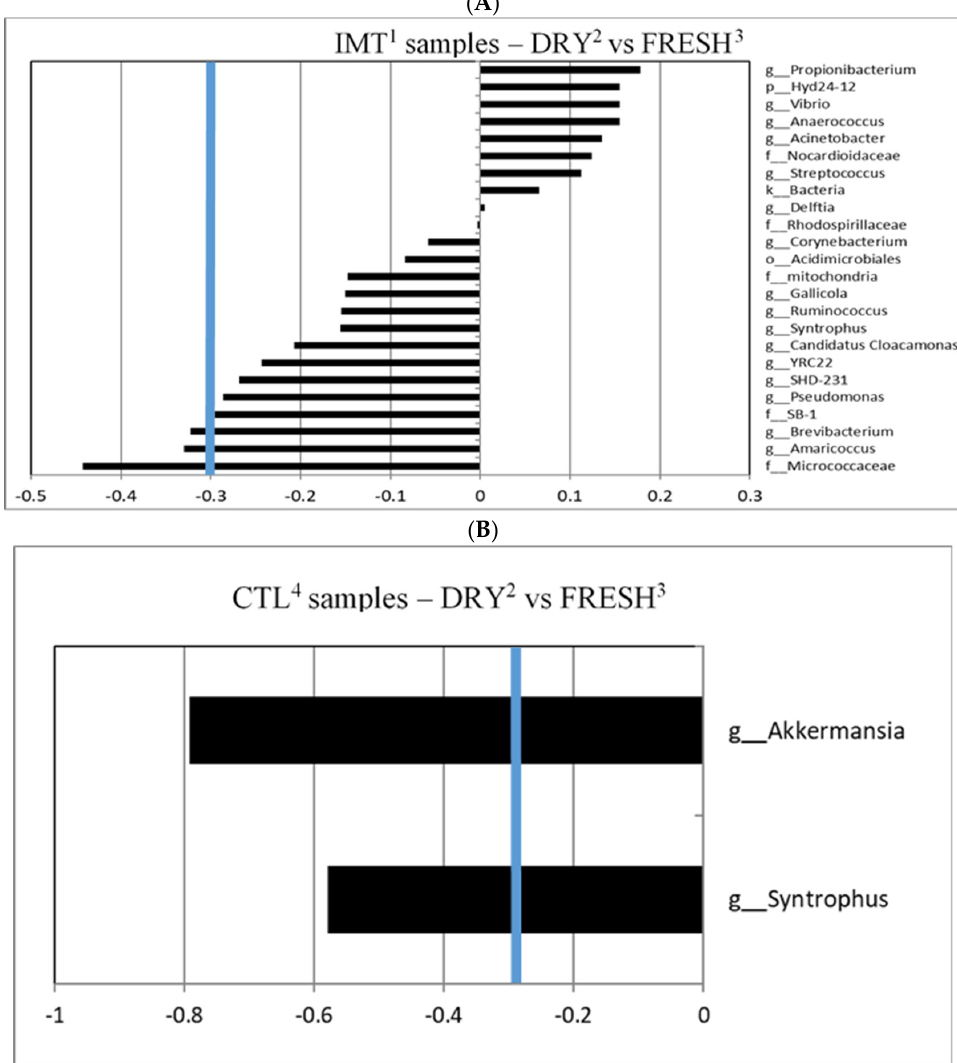
Figure 4. Canonical structure coefficients comparing sampling microbiota for milk collection sampling points (DRY and FRESH) by treatment group, namely cows either receiving intramammary antimicrobial treatment (IMT) at dry-off and cows not receiving IMT at dry-off (CTL). ( A ) Correlation between microbial taxa and the discriminant function for DRY vs. FRESH sampling points of IMT cows. Bacterial taxa with canonical structure coefficients ≤− 0.3 or ≥ 0.3 (blue line) are considered important when distinguishing sampling times (DRY vs. FRESH) from IMT and CTL cows. ( B ) Correlation between microbial taxa and the discriminant function for DRY vs. FRESH sampling points of CTL cows. 1 IMT: treatment group representing cows receiving intramammary antimicrobial drug treatment at dry-off; 2 DRY: samples collected at the time of dry-off; 3 FRESH: samples collected from post-partum cows between 4 and 11 days in milk; 4 CTL: control group representing cows not receiving intramammary antimicrobial drug treatment at